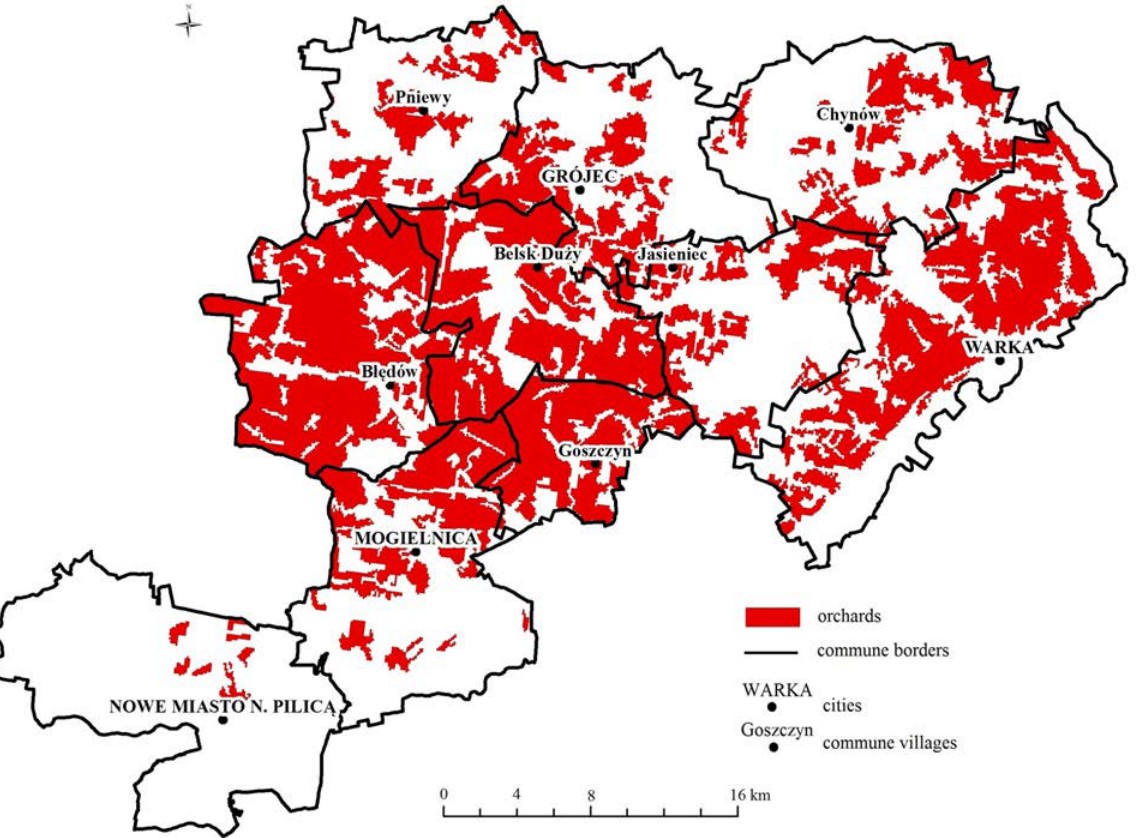
Fig. 7. Distribution of orchards in Grójec poviat in 2006. Source: own study based on Corine Land Cover